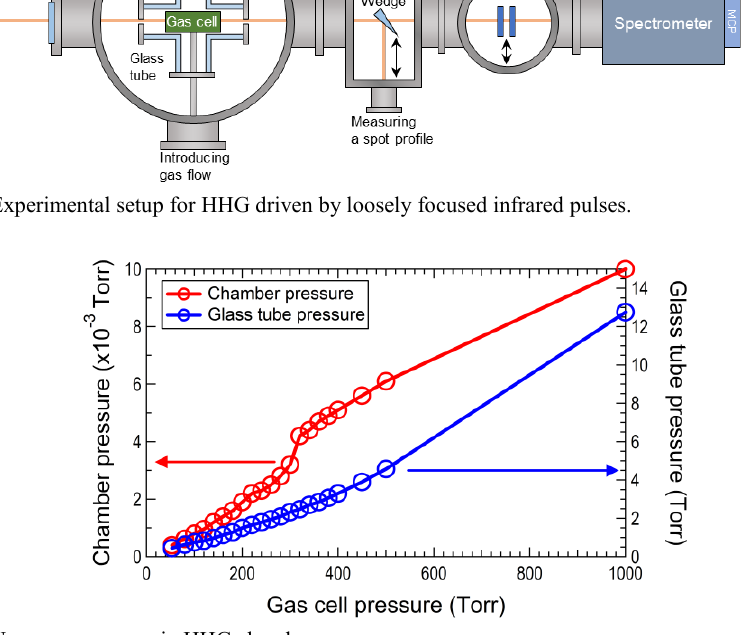
Fig. 2. Neon gas pressure in HHG